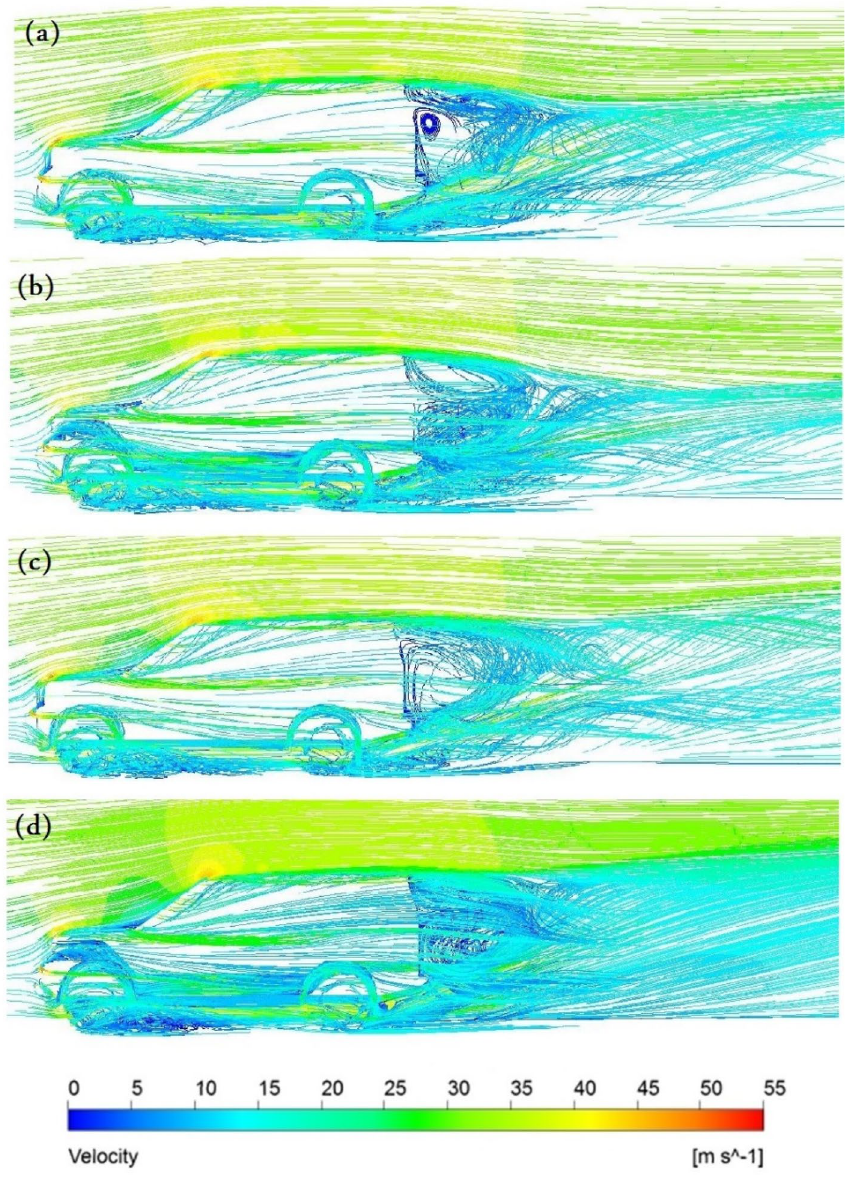
Figure 15. Pathlines ( a ) the baseline model, ( b ) the ventilation duct, ( c ) the roof modified model, ( d ) modified combined